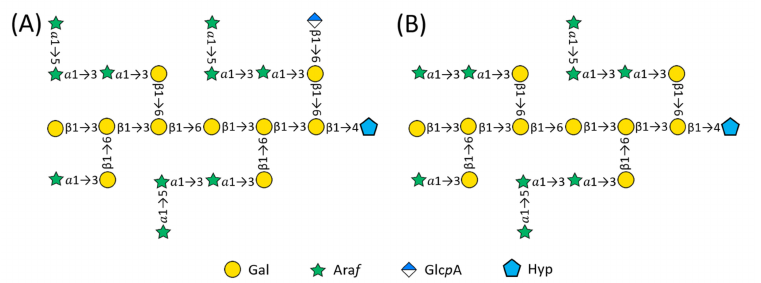
Figure 3. Proposed structures of AtSPHP-1 and -2. ( A ) AtSPHP-1 is composed of β -Gal p , α -Ara f , β -Glc p A, and Hyp in a ratio of 10:10:1:1. ( B ) AtSPHP-2 contains β -Gal p , α -Ara f , and Hyp in a ratio of